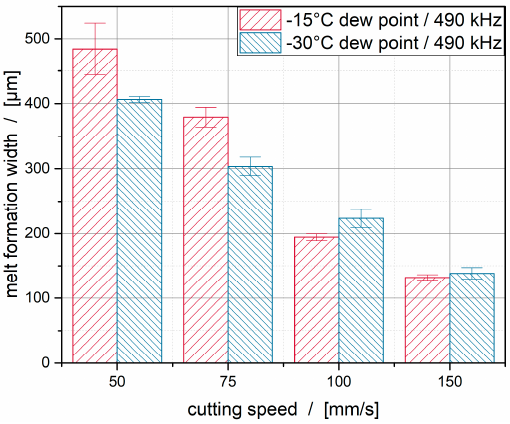
Figure 15. Influence of the cutting speed and dew point on the melt formation width.